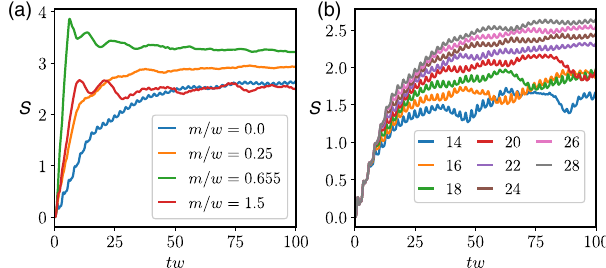
FIG. 10. Evolution of entanglement entropy in the FSS model. (a) Growth of the half-chain entanglement entropy for various values of the particle mass m . Initial state is CDW or, equiv- alently, a string, and L ¼ 28 . (b) Growth of entanglement entropy for different sizes L . Initial state is CDWor, equivalently, a string, and m ¼ 0 entropy S ð t Þ of the chain. We consider as initial state the CDW, which is equivalent to considering the QLM evolv- ing from one of the two uniform string configurations; see Fig. 1. In order to determine S , we compute the time- dependent reduced density matrix ˆ ρ ð t Þ of a subsystem R consisting of L= 2 consecutive sites of the chain, by tracing out the degrees of freedom of the remaining complemen- tary L= 2 sites. In these terms, the von Neumann entangle- ment entropy is defined by S ð t Þ ¼ − Tr ½ ˆ ρ ð t Þ ln ˆ ρ ð t Þ(cid:2) . R R Figures 10(a) and 10(b) show the evolution of S for various values of the mass m and of the chain length L , respectively. Information spreading is directly tied to par- ticle production: it is fast at the critical point m ¼ m c [green curve in Fig. 10(a)] with m c =w ¼ 0 . 655 , or above it m > m c (red curve), where particles are not confined. For m < m c (yellow and blue curves), instead, it slows down consid- erably, as was already observed in the spin-1 QLM [26]. For m=w ¼ 0 , the change in the original slope of the curvewhich occurs around tw ≃ 12 is due to a finite-volume effect, as demonstrated in Fig. 10(b), where such a change progres- sively disappears upon increasing L . In all cases, the fast oscillations correspond to different stages of pair production.